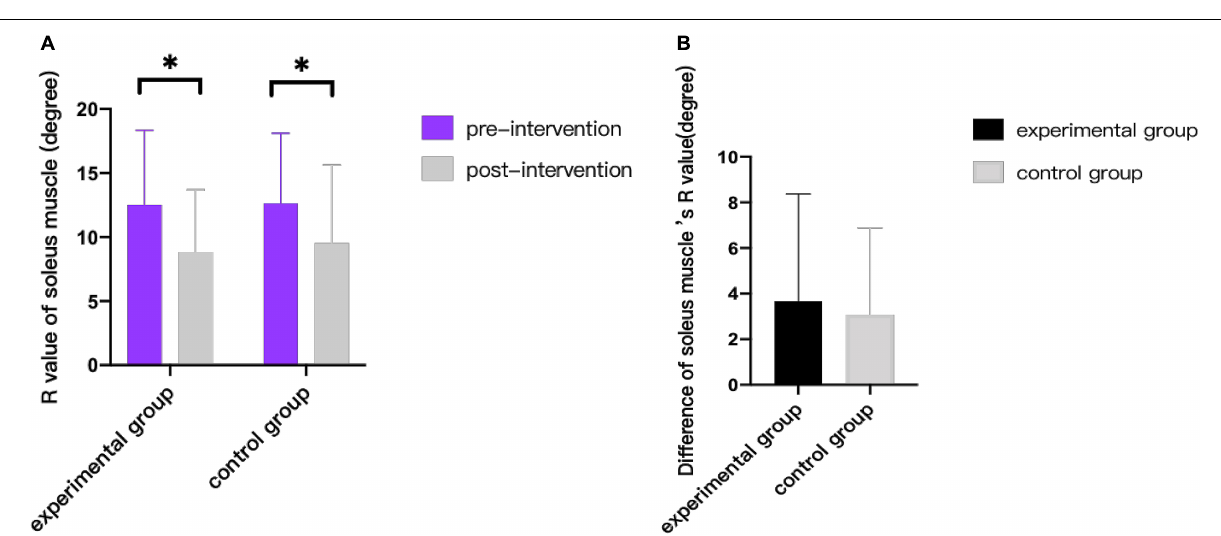
FIGURE 6 | Comparison of R value of soleus muscle. * indicates intra-group p <